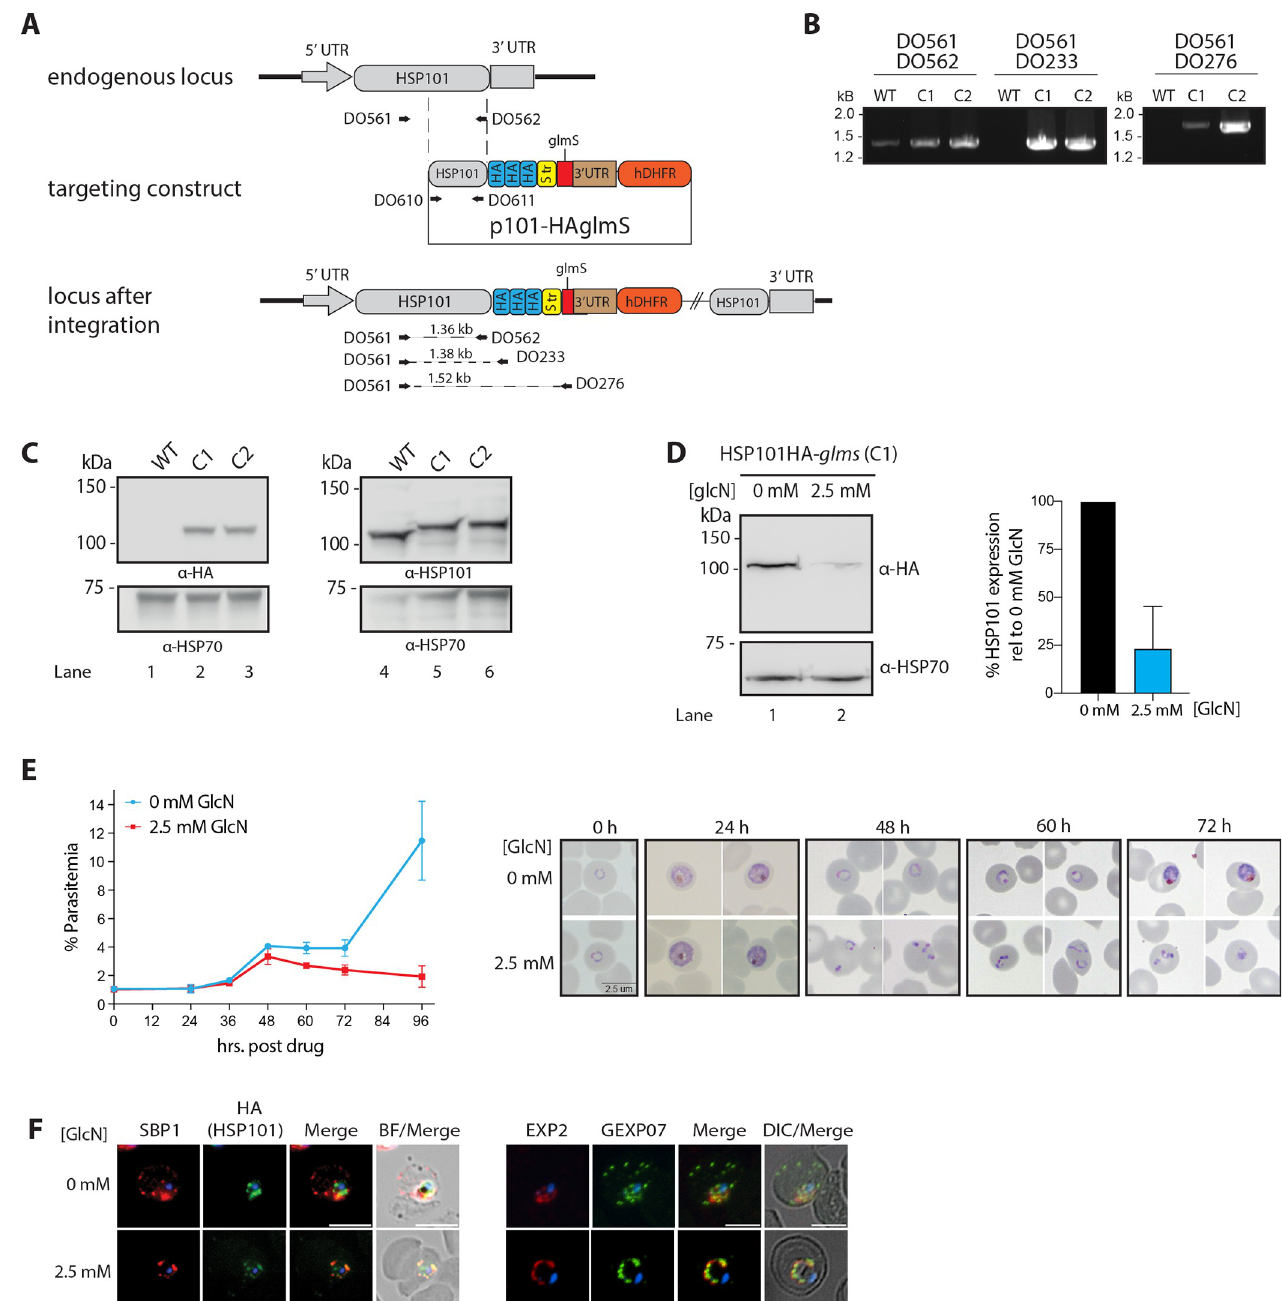
Fig 1. Generation and validation of HSP101-HA glmS parasite line and knockdown analysis. (A) The P . falciparum HSP101 targeting construct integrated into the endogenous locus by a single crossover recombination event as indicated. Hemagglutinin (HA) and strep II (Str) epitope tags, human DHFR selectable marker (hDHFR), glmS ribozyme and untranslated regions (UTR) are shown. Arrows indicate oligonucleotides used in diagnostic PCR analysis and their product sizes. (B) Diagnostic PCR showing the hsp101 gene contains the integrated sequence. Oligonucleotide pairs shown in (A) were used on genomic DNA prepared from 3D7 wildtype parental parasites (WT) or from two independent clones of drug-resistant parasites obtained after transfection with the targeting construct (C1, C2). DO561 and DO562 recognize the hsp101 locus and serve as a positive control for the PCR. (C) Western blot analysis showing that the HSP101-HA glmS C1 and C2 express the HA epitope tags. Rabbit HSP101 and HSP70-1 antibodies serve as loading controls. (D) Representative western blot demonstrating HSP101 expression can be knocked down using glucosamine (GlcN). Left panel: Synchronised cultures of ring-stage PfHSP101-HA glmS parasites grown in the presence or absence of GlcN for 48 hours were harvested and parasite lysates were probed with anti-HA antibodies to detect HSP101-HA expression. HSP70-1 served as a loading control. Right panel: Densitometry performed on bands observed by western blot using ImageJ to quantitate the level of HSP101 expression relative to HSP70-1 in parasite lines grown in the presence or absence of GlcN. Shown is the mean ± SEM (n =